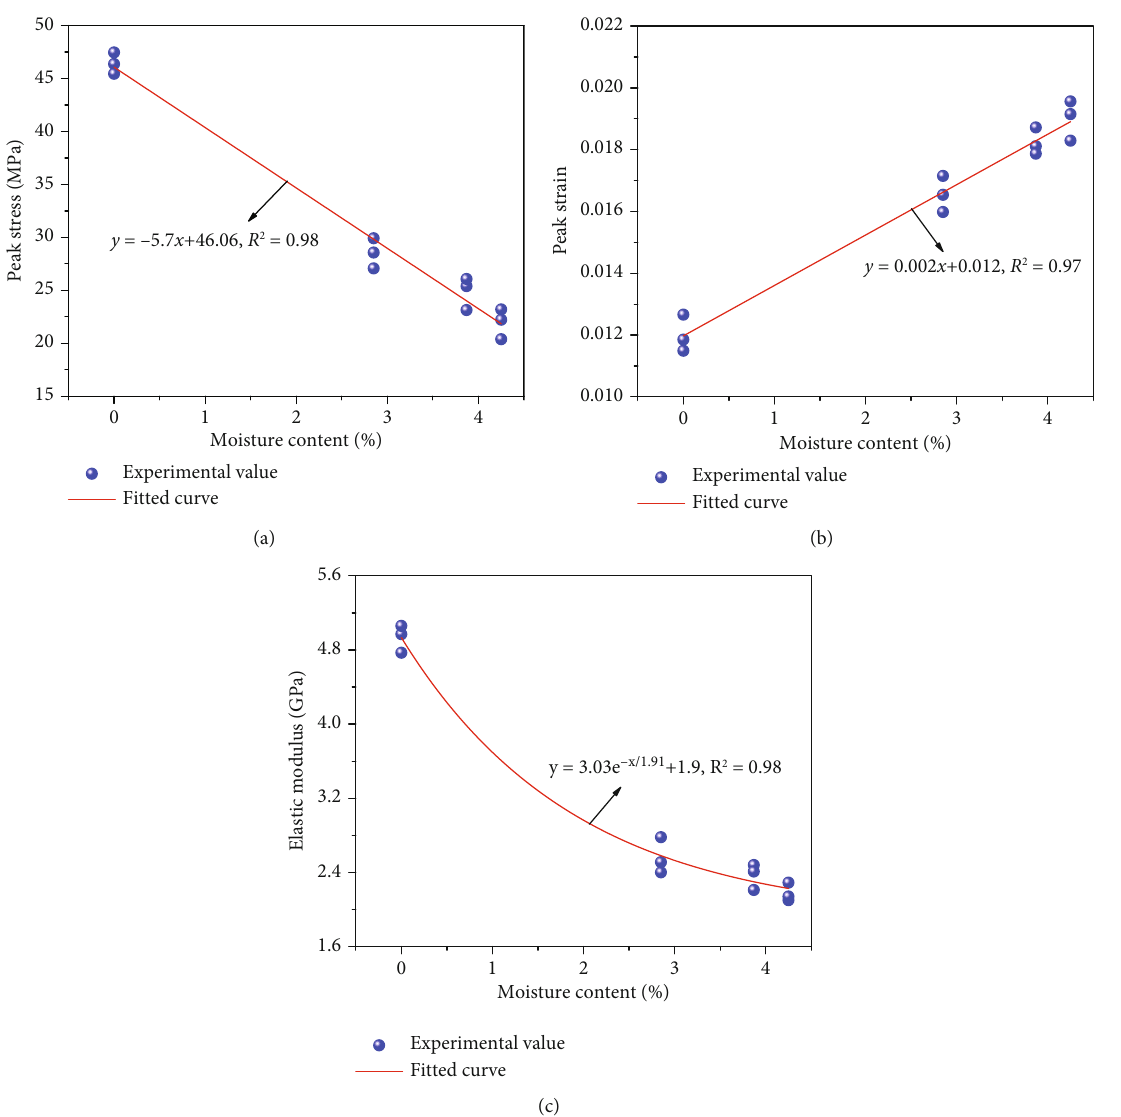
Figure 7: Relationship between peak stress, peak strain, elastic modulus, and moisture content. (a) Peak stress moisture content curve, (b) peak strain moisture content curve, and (c) elastic modulus moisture content